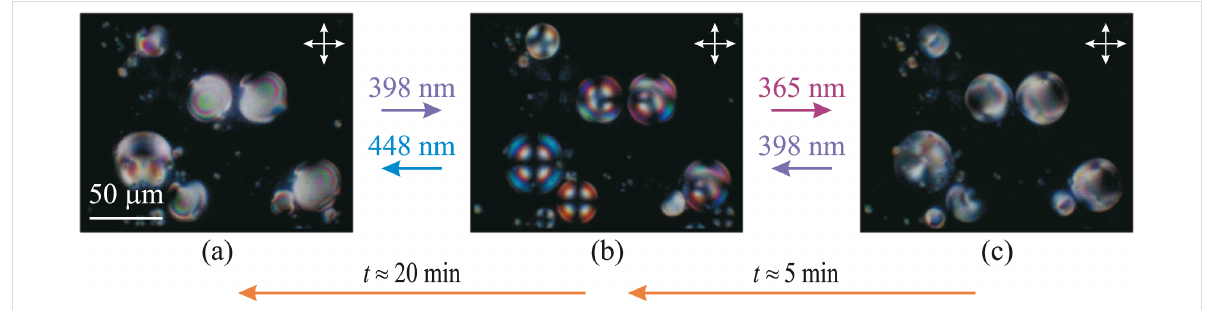
Figure 2: POM images of NLC droplet structures in the bulk of glycerol obtained at light-emitting diode irradiation with wavelengths of (a) 448 nm, (b) 398 nm and (c) 365 nm. The arrows show the direction of transitions. The double arrows show the directions of the crossed polarizers.